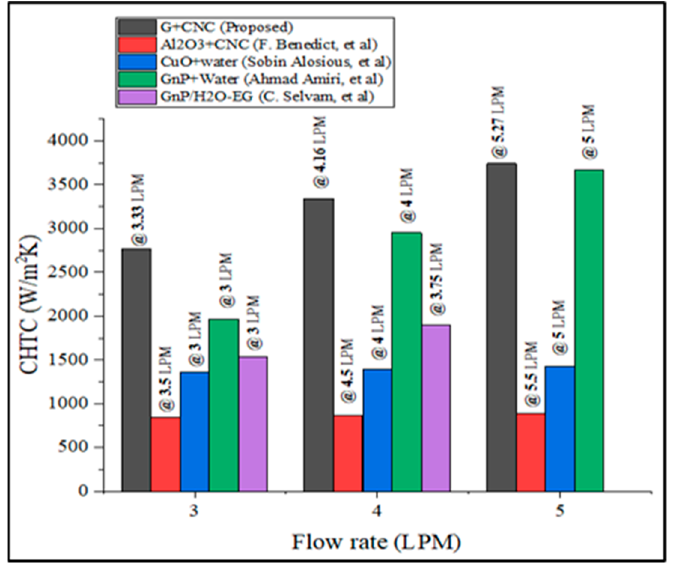
Figure 24. Comparison of CHTC of the present study with previous literature [63–66].